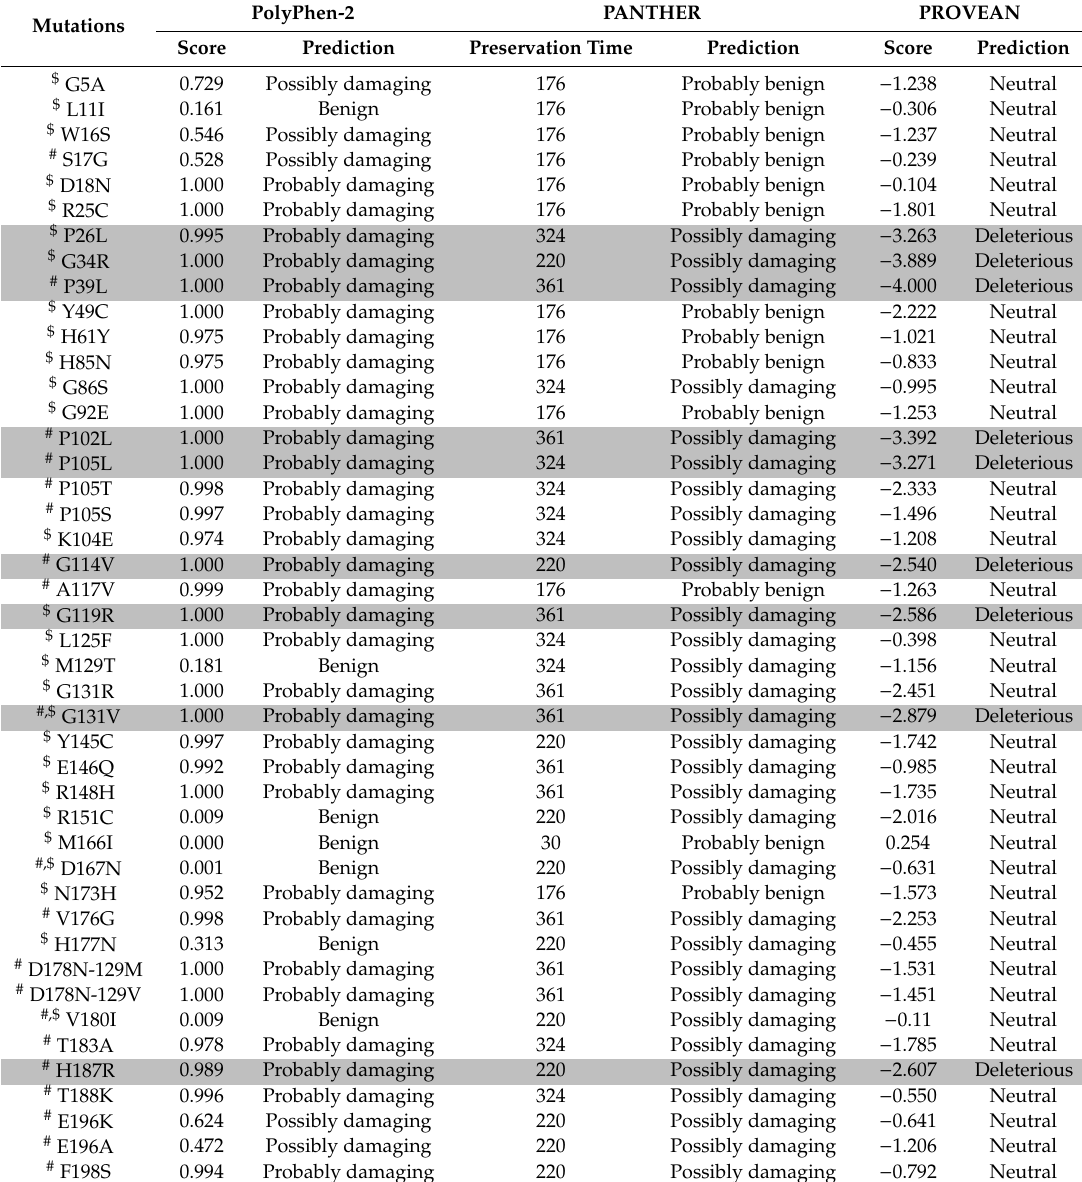
Table 4. In silico annotations of PRNP somatic mutations in cancer